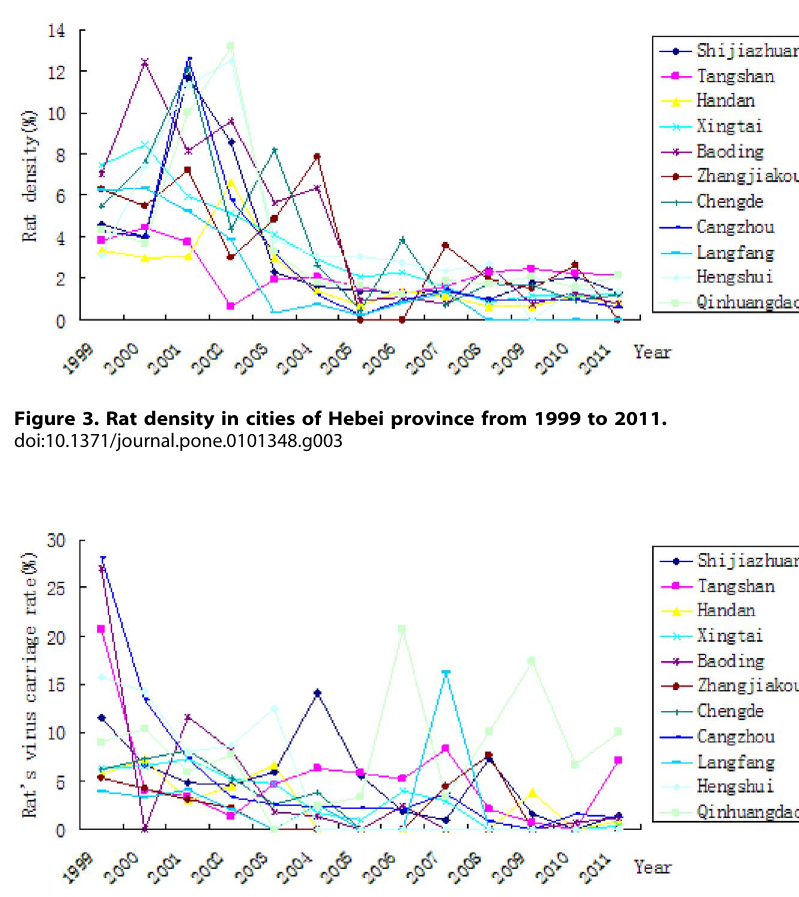
Figure 4. Rat’s virus carriage rate in cities of Hebei province from 1999 to 2011. doi:10.1371/journal.pone.0101348.g004 PLOS ONE |